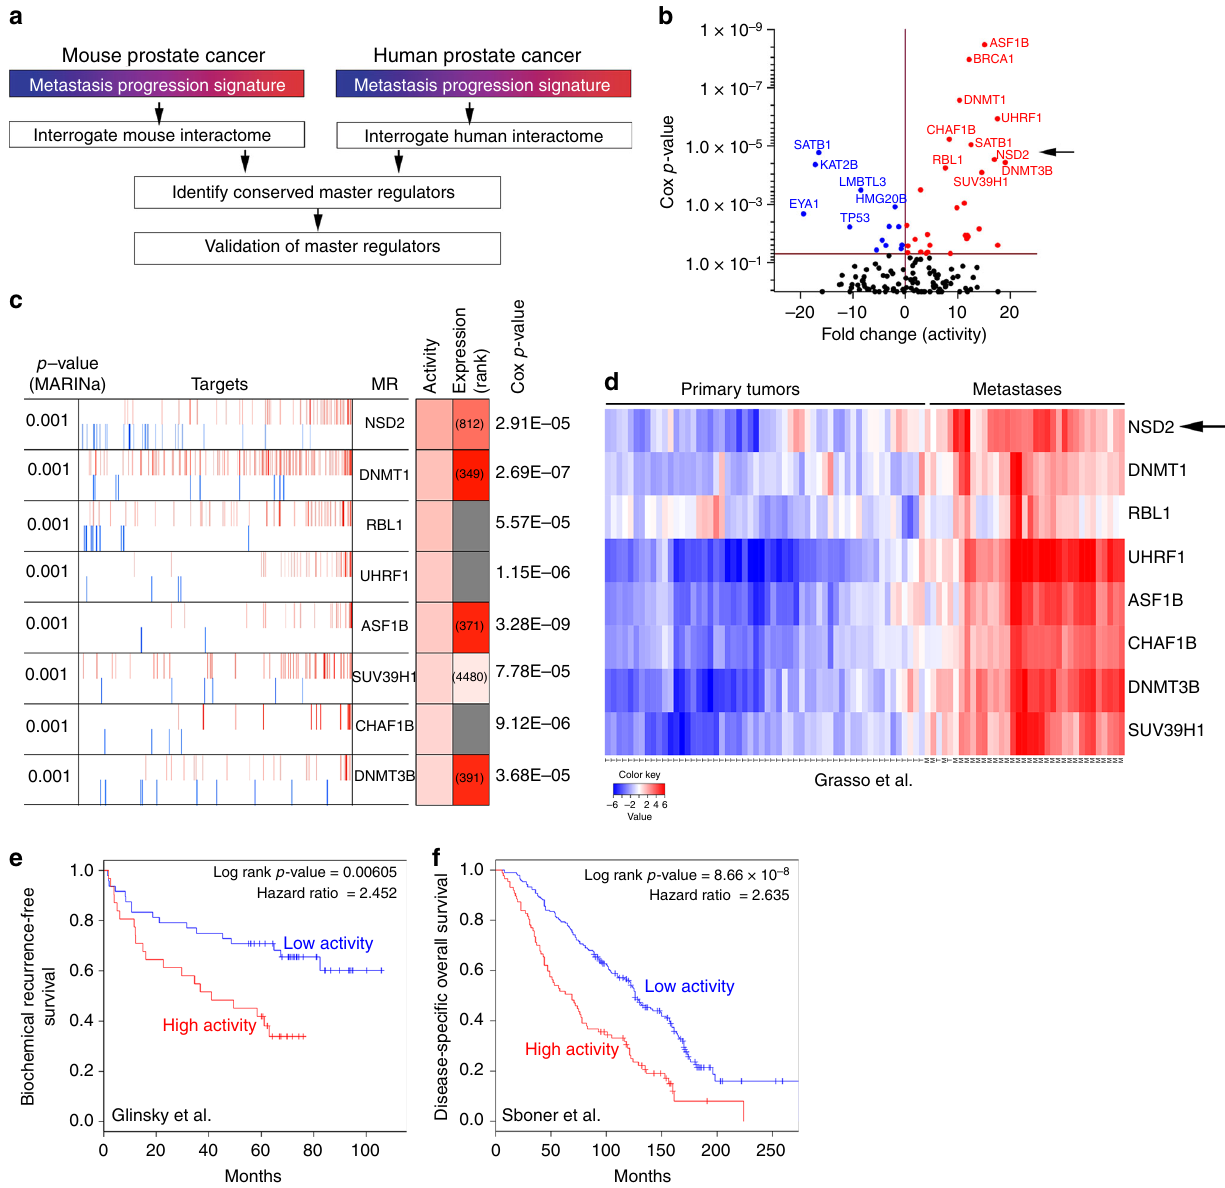
Fig. 3 Conserved master regulators of metastasis progression. a Strategy: mouse and human metastasis progression signatures (as in Fig. 2f) were used to interrogate mouse and human prostate cancer interactomes, respectively, using the MARINa algorithm. Independent lists of mouse and human master regulators (MRs) were integrated to identify conserved MRs, which were prioritized by clinical and functional validation. b Scatter plot showing the association of the 136 conserved MRs (Supplementary Data 3) to clinical outcome using the Sboner et al. dataset, which reports prostate cancer-speci fi c survival as the clinical endpoint (Supplementary Table 1). The Y axis represents the Cox proportional hazard p -value and the X axis represents the fold change based on MR activity. MRs that are inactive (blue) relative to primary tumors have negative fold change values and those that are active (red) have positive fold change values. c Summary of the 8 candidate MRs depicting their positive (activated; red bars) and negative (repressed; blue bars) targets. Shaded boxes show the ranks of differential activity and differential expression (darker is higher and lighter is lower); the numbers indicate their rank in the differential expression signature (gray indicates that a speci fi c gene is not present on the utilized gene expression platform, yet its targets are present). P - values for Cox proportional hazard were estimated using a Wald test based on time to prostate cancer-speci fi c death in Sboner et al. d Heatmap showing hierarchical clustering of primary tumors and metastasis from the Grasso et al. cohort (Supplementary Table 1) based on the activities of the 8 candidate MRs. The color key shows activity levels of MRs (i.e., NESs), where red corresponds to increased activity and blue correspond to decreased activity of the MRs. e , f Kaplan – Meier survival analysis based on the activity levels of the 8 candidate MRs in: e Glinsky et al. ( n = 79), with biochemical recurrence as the clinical end-point; and f Sboner et al. ( n = 281), with prostate cancer-speci fi c survival as the clinical endpoint (Supplementary Table 1). P -values were estimated using a log-rank test to determine the difference in outcomes between patients with higher MR activity levels (red) versus those with